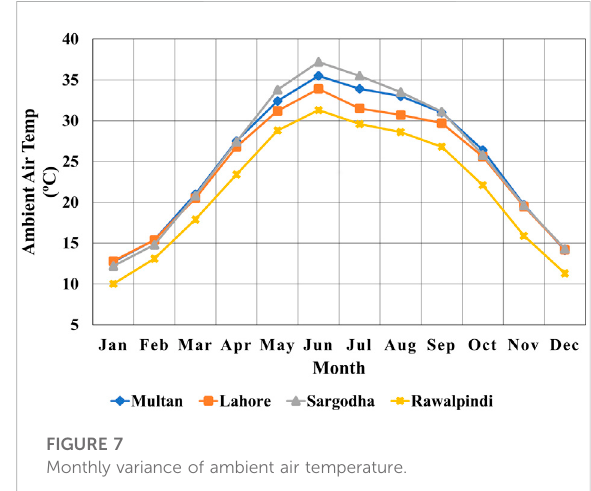
FIGURE 6 Monthly variance of average daily solar irradiation.